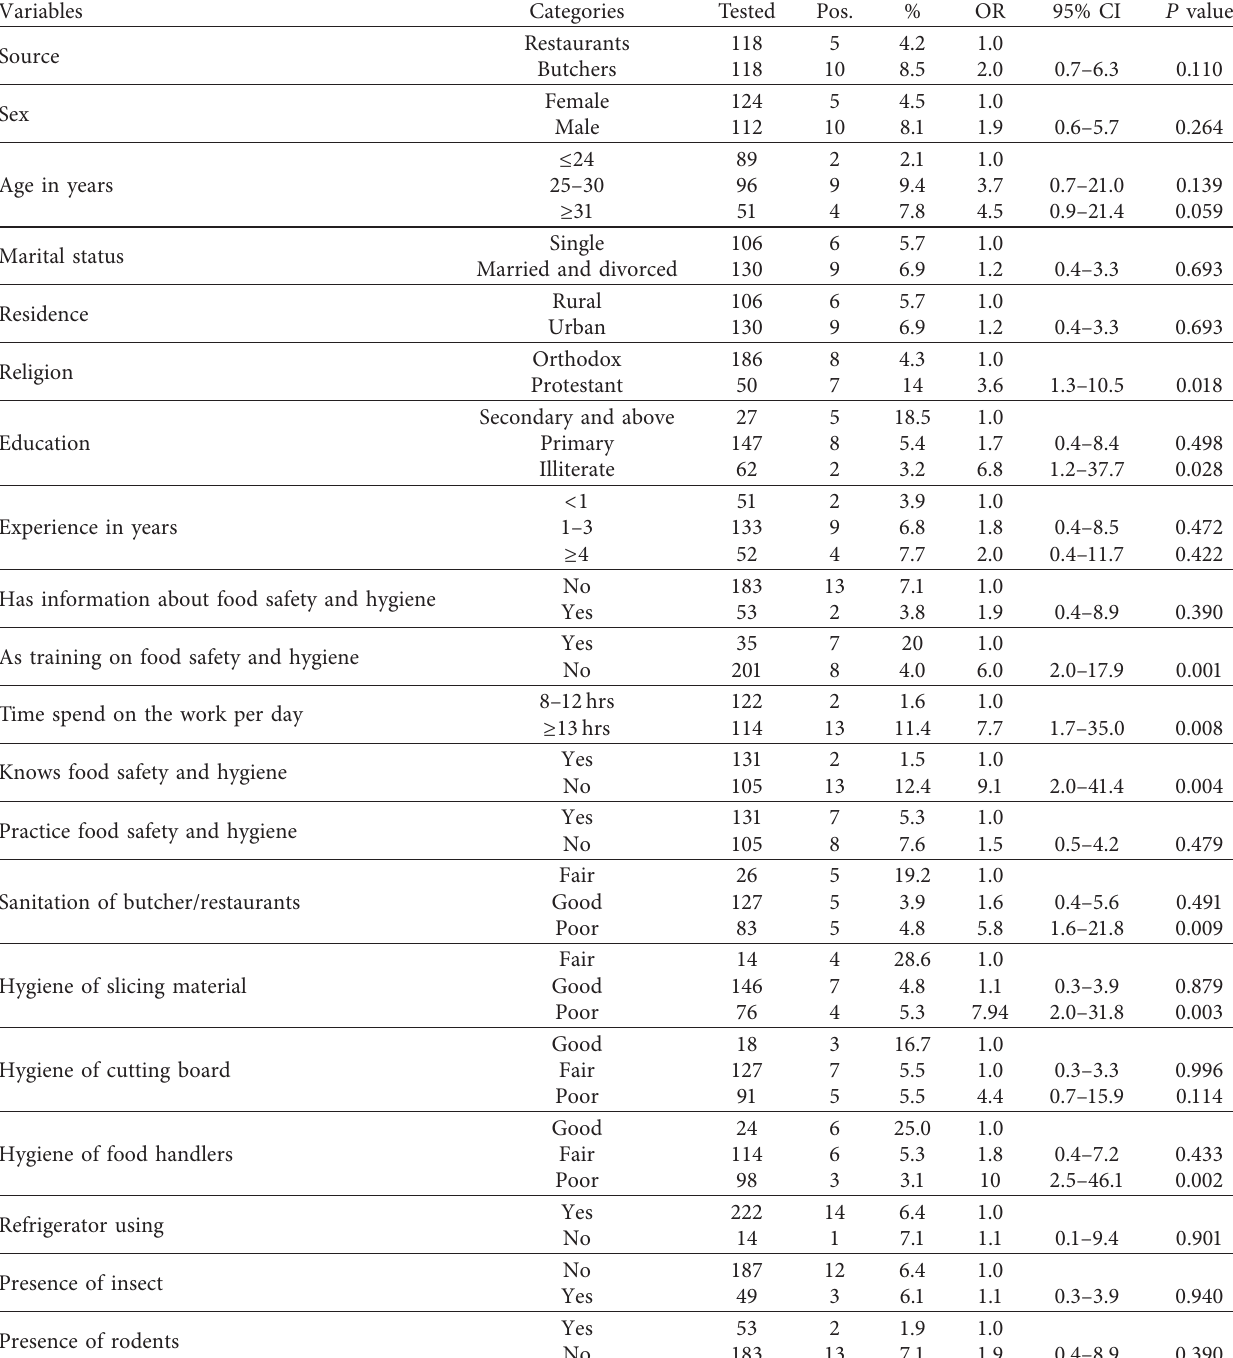
Table 7: Univariable logistic regression analysis of factors associated with meat contamination with Salmonella in butcher and restaurants of Ambo and Holeta